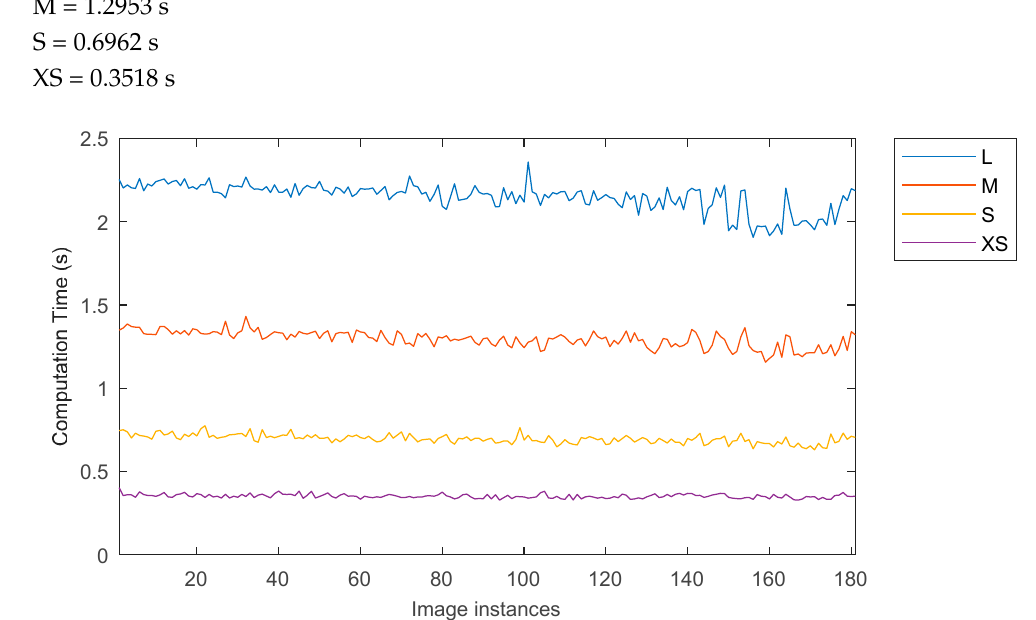
Figure 19. Computation time vs. image resolutions for D2 dataset.